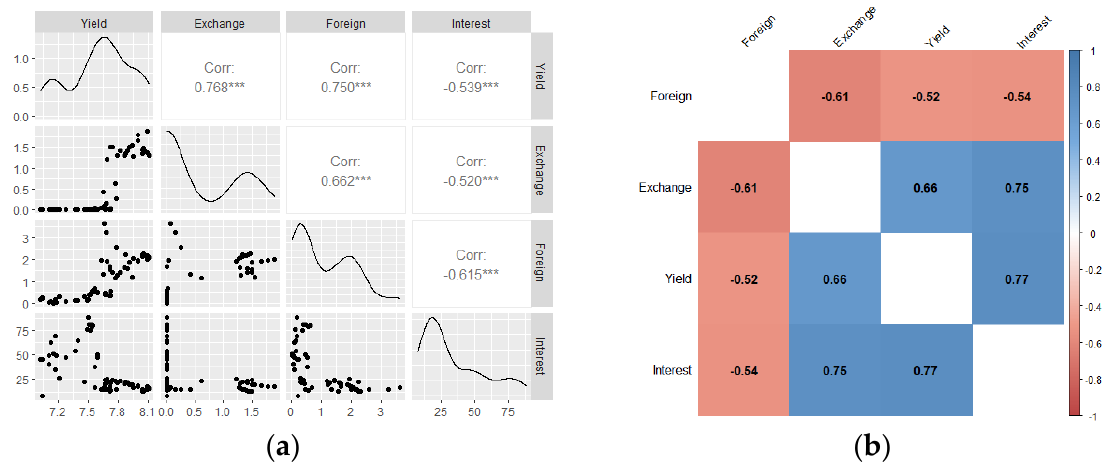
Figure 1. Pairs of parametric covariates and correlogram with response variable log(𝑌𝑖𝑒𝑙𝑑) . ( a ) Pairs with densities and correlations . ( b ) Correlogram . Asterisks (***) denote that correlations are statistically significant in 95% confidence level. Nonparametric covariate: